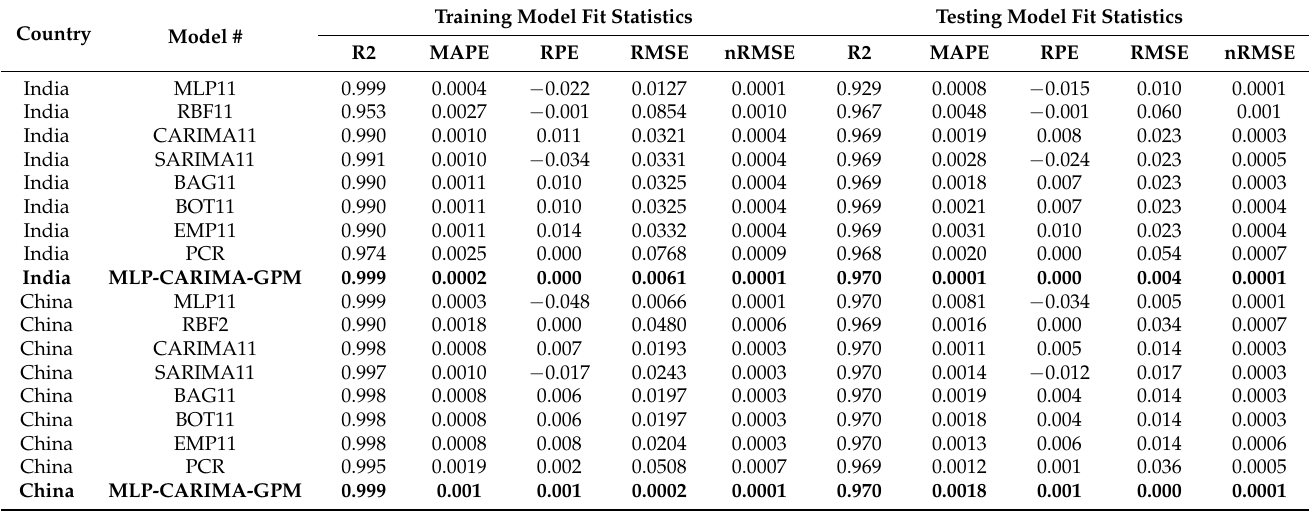
Table 8. Best-performing models for China and India.